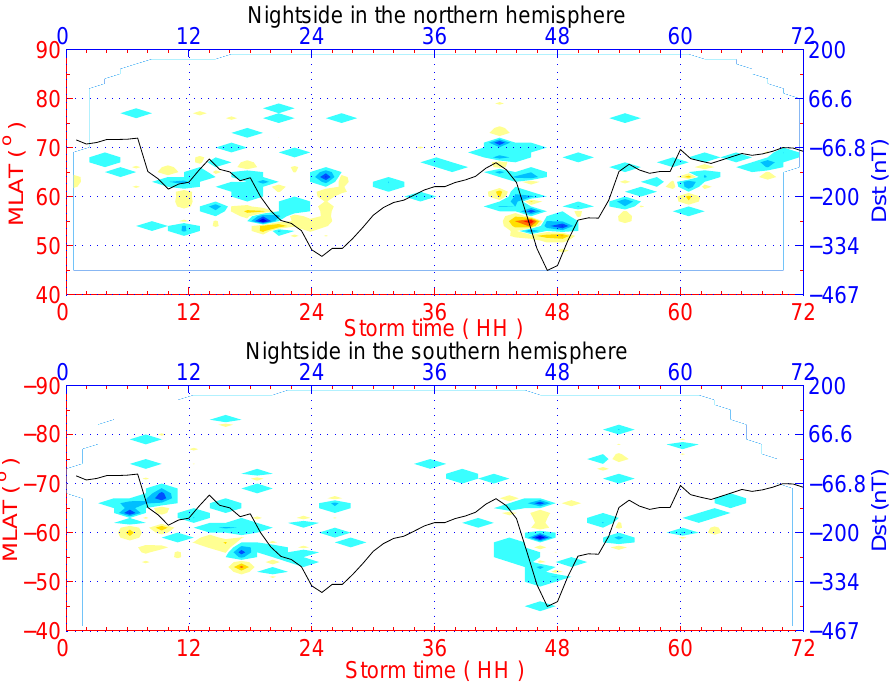
Fig. 5. Latitudinal variation of the FACs occurrence on the nightside in comparison with the D st value in both hemispheres for the October